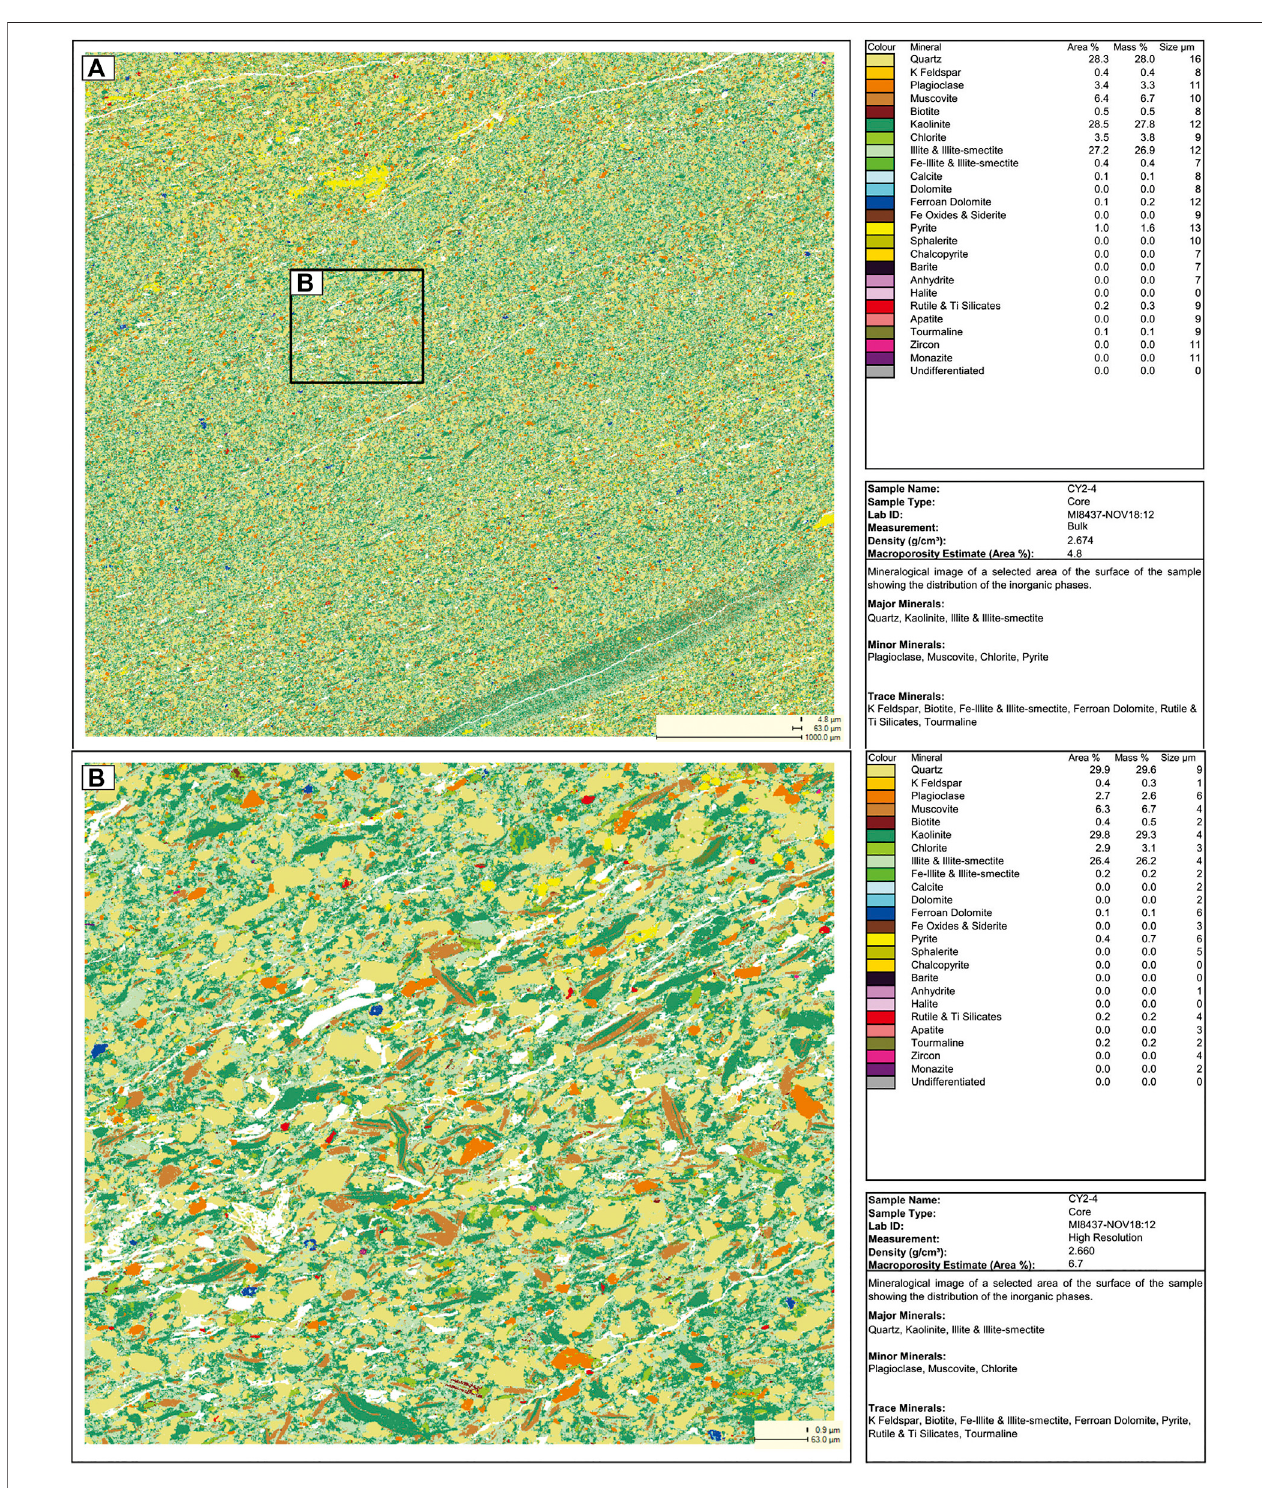
FIGURE 6 | QEMSCAN image of sample CY2-4. (A) Bulk measurements and (B) high-resolution measurements.